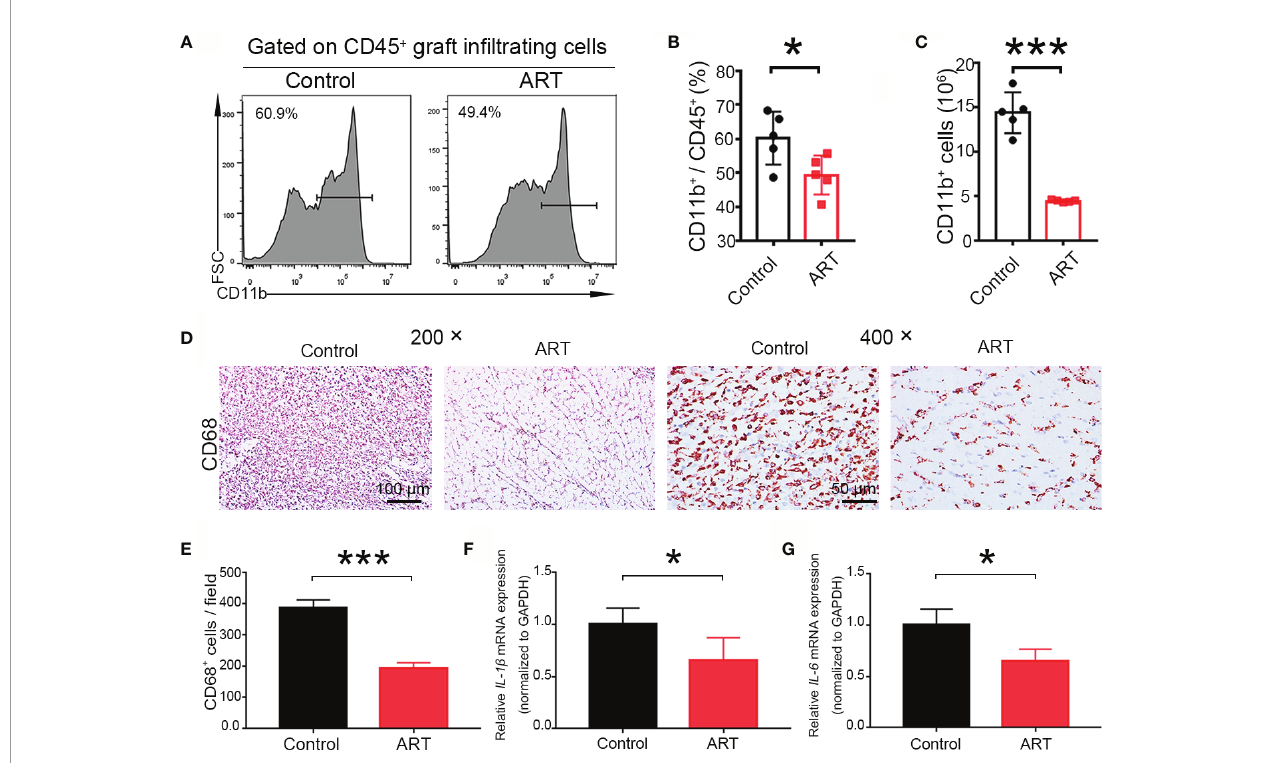
FIGURE 5 | Artemisinin (ART) suppresses the number and function of macrophages in vivo . (A – C) Macrophages (CD11b + ) were detected by fl ow cytometry in allografts on day 5 after cardiac transplantation, and the representative histograms for frequencies and counts of macrophages in cardiac grafts (D, E) are shown. Representative immunohistochemistry staining images and quantitative analysis of cell number/view, based on CD68, in the control and ART groups (n = 5/group). (F, G) ART inhibited the mRNA expression of IL-1 b and IL-6 . The mRNA levels were normalized to those of GAPDH . Three independent experiments were performed showing similar results. Data were expressed as the mean ± SD. * P < 0.05; *** P < 0.001. Magni fi cation: 200× and